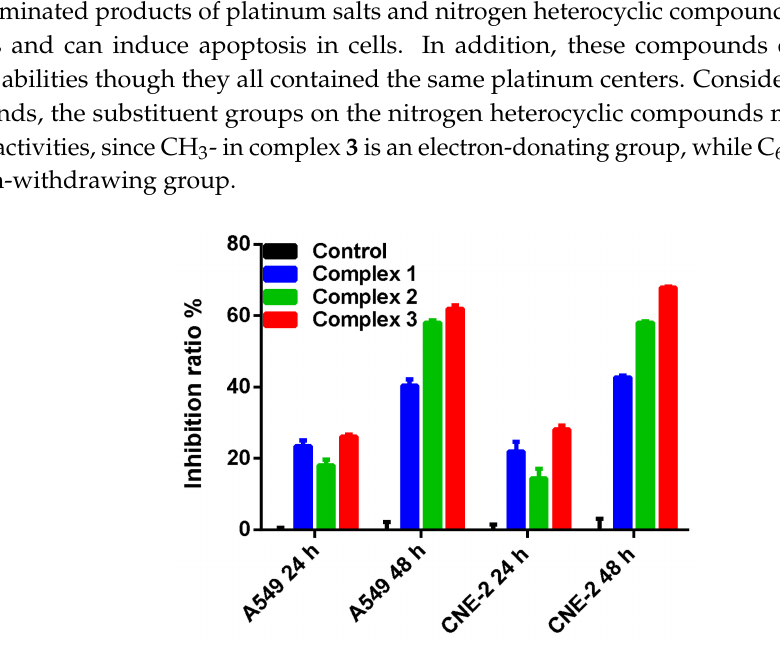
Figure 10. Induction of apoptosis in tumor cells by complexes 1 – 3 .